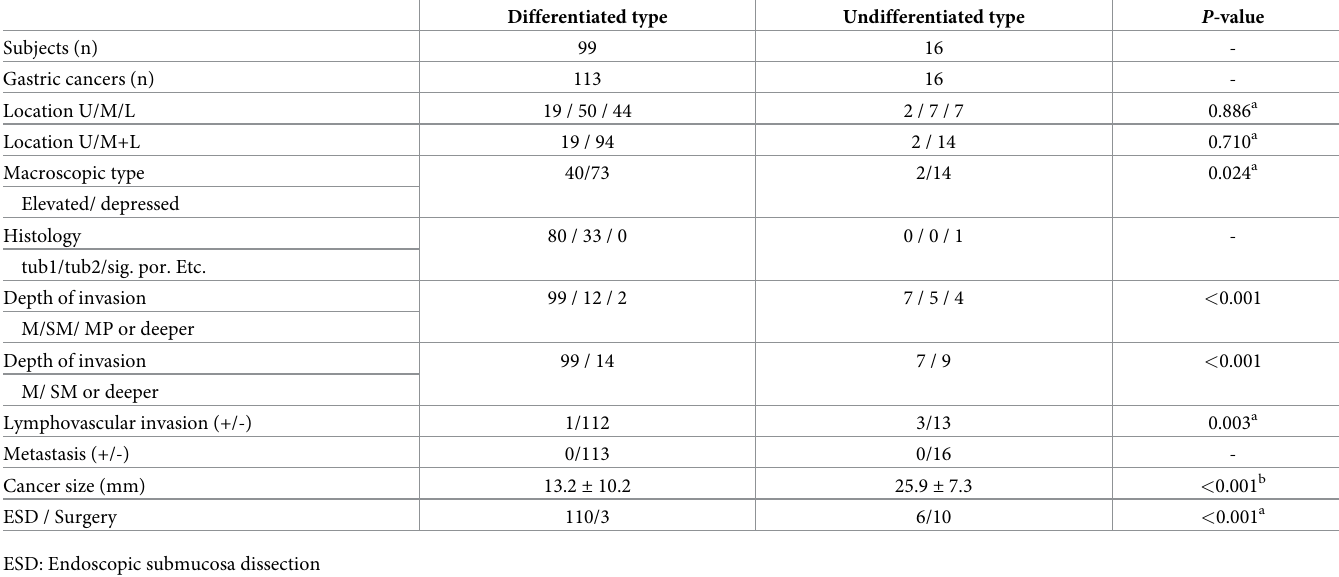
Table 2. Comparison between differentiated and undifferentiated adenocarcinoma after H . pylori